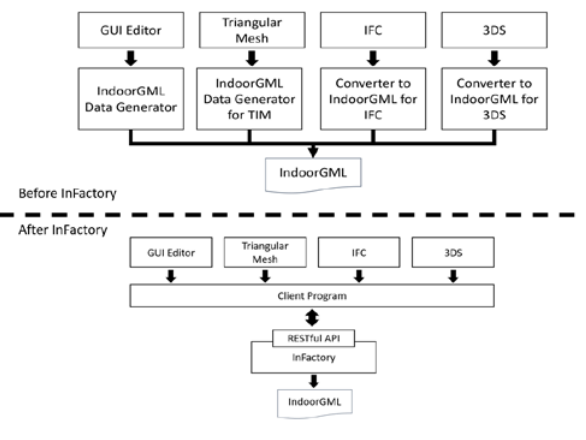
Figure 1. The systems which can use InFactory